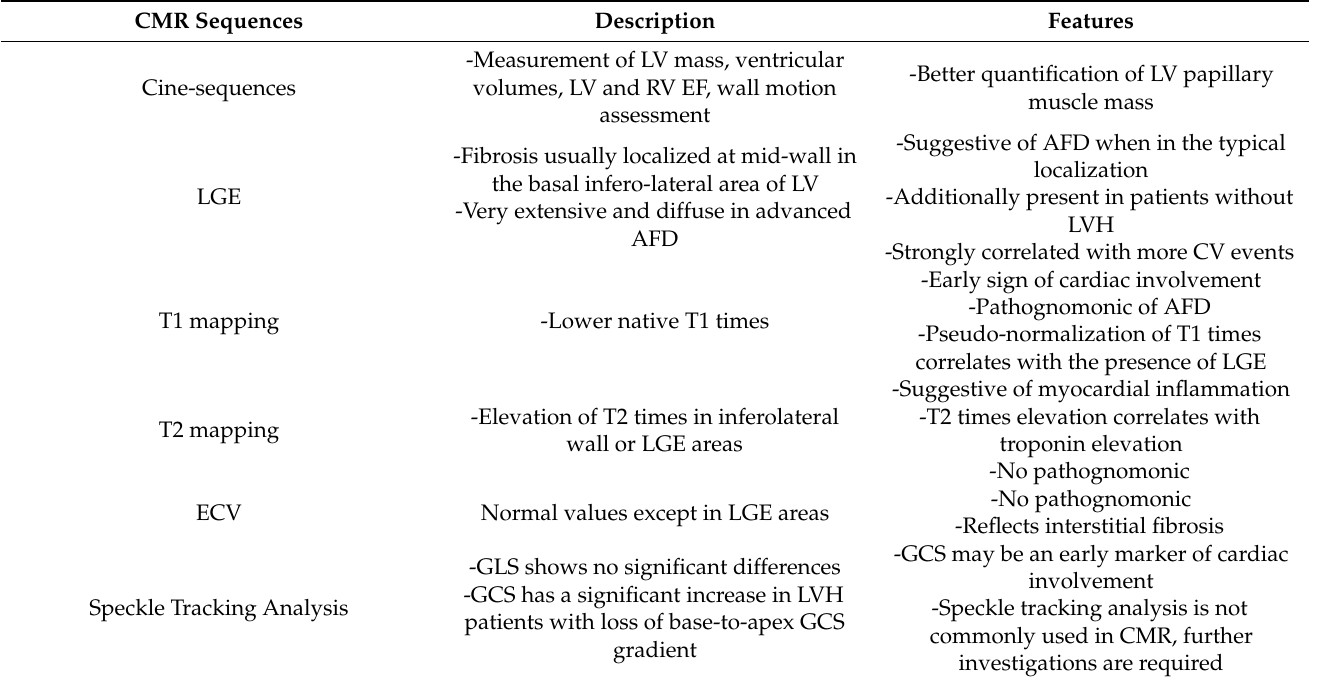
Table 3. Cardiovascular magnetic resonance in AFD